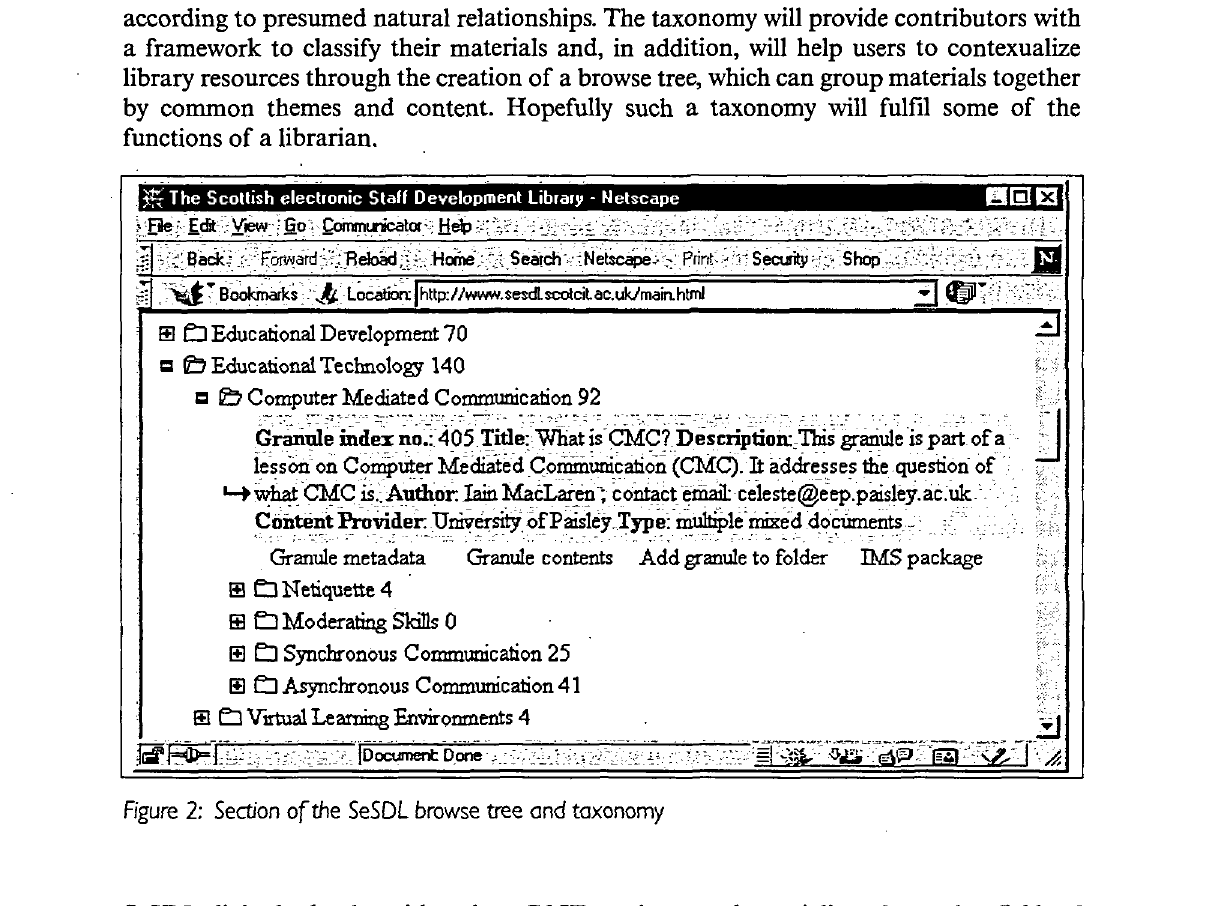
Figure 2: Section of the SeSDL browse tree and